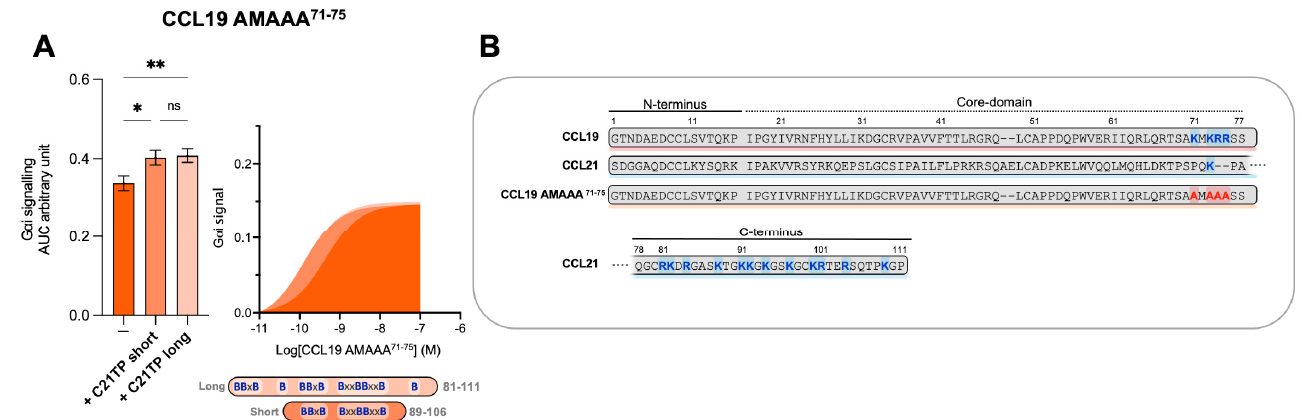
Figure 5. Removing C-terminal basic residues in CCL19 improves basal activity but does not boost activity in G α i signaling. ( A ) Areas under the curve (AUCs, arbitrary units) of cAMP signaling are shown as bar graphs and AUC curves. The length and location of BBx(x)B motifs in the short and long C21TPs are shown as graphical bars. The effect of short (89–106) and long (81–111) C21TPs on G α i signaling in response to CCL19 AMAAA 71 − 75 was measured using BRET-based assays. C21TPs were added for a final concentration of 10 µ M. Statistical significances were determined using one-way ANOVA with Tukey’s multiple comparisons test ( n = 3). * p < 0.05, ** p < 0.01, ns non significant. ( B ) Alignments of chemokine sequences; CCL19, CCL21, and CCL19 AMAAA 71 − 75 . Basic residues in the C-terminal region of the chemokines are written in bold and marked with blue. The alanine substitutions K71A, K73A, R74A, and R75A are written in bold and marked with red.